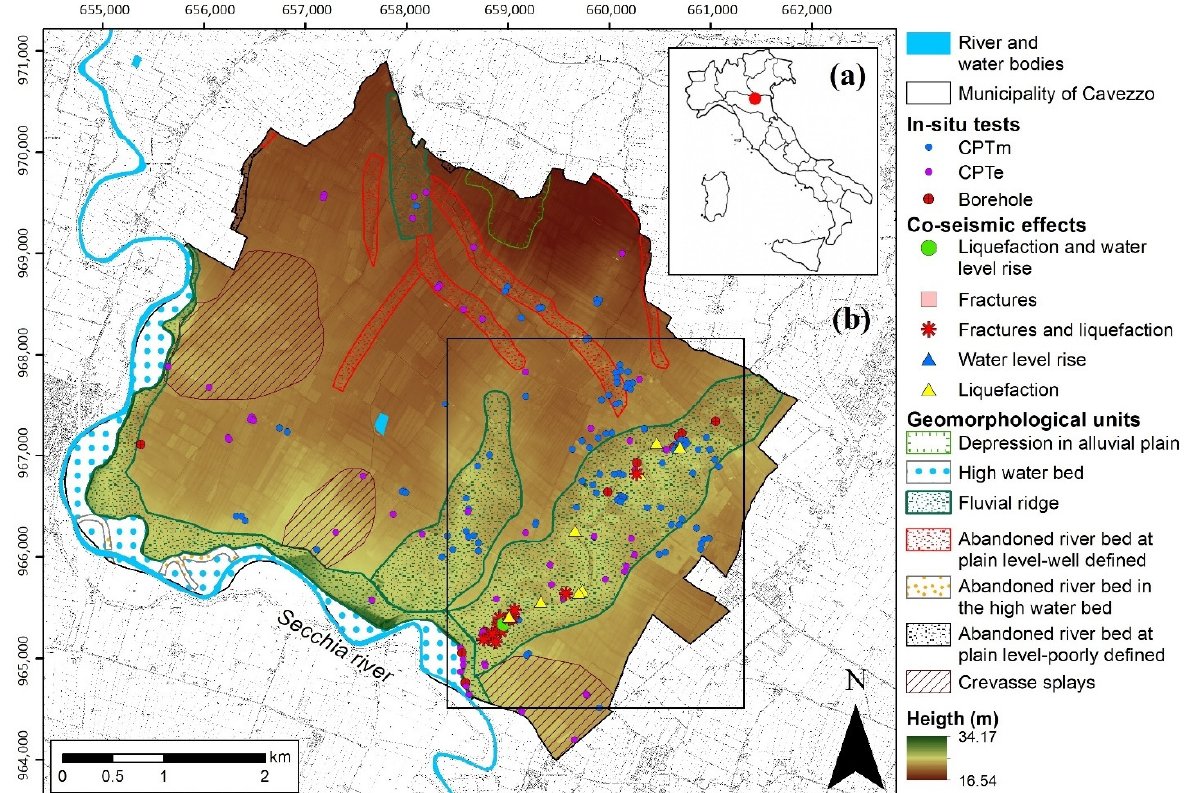
Figure 1. ( a ) Location of the Cavezzo testing site. ( b ) Geomorphological setting of the study area, digital elevation model with a spatial resolution of 1m, and distribution of the observed co-seismic effects; the available geotechnical investigations are also reported. The black box is the area of the abandoned riverbed, represented in Figure 3.